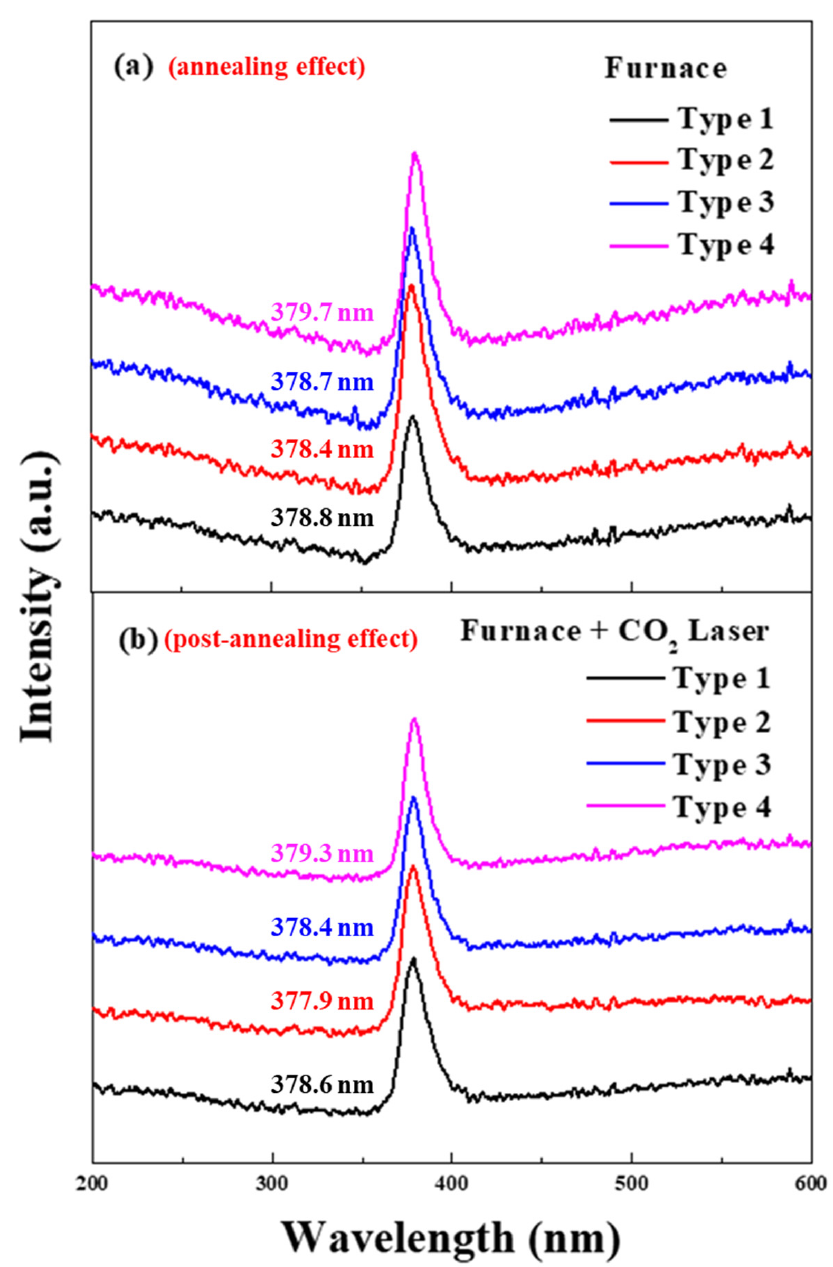
Figure 8. Photoluminescence spectra of 4 types of (In, Ga) co-doped ZnO multilayered thin films after